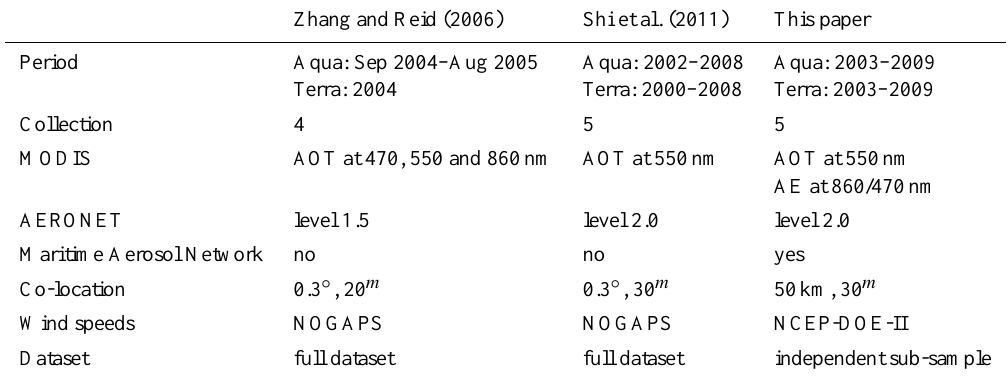
Table 1. Comparison between three relevant studies.